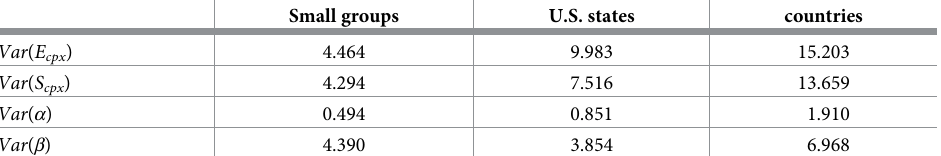
Table 3. Variance of best parameter values for each small group, U.S. state, and country after 1000 realization via simulated annealing.